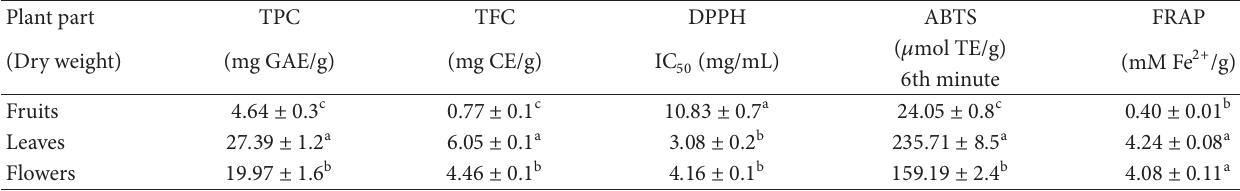
Table 1: Total phenolic content and total flavonoid content and antioxidant capacity.